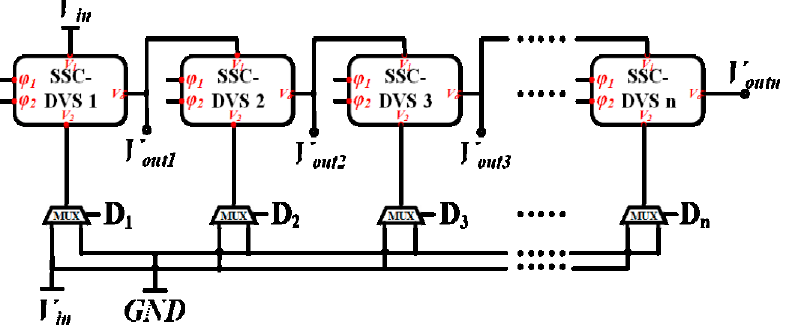
Figure 2. Block diagram of the proposed n -bit SSC-DVS (Dynamic Voltage Scaler) architecture.